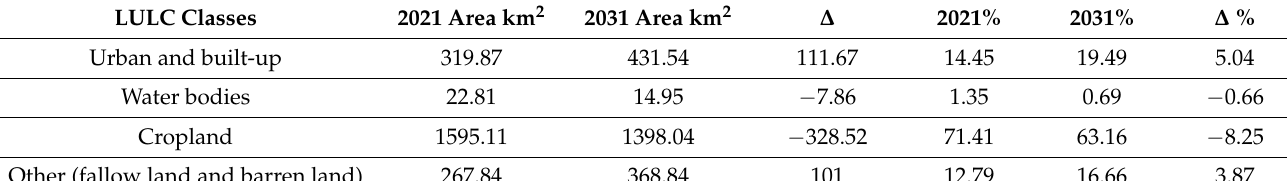
Table 4. Analysis of the LULC forecast for 2031 based on the LULC maps of 2011 and 2021.